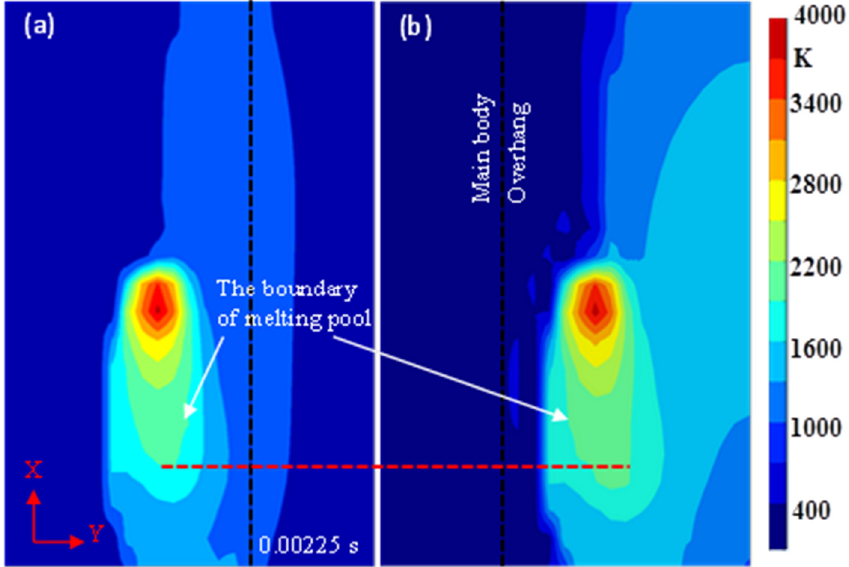
Figure 2. The temperature distribution on the X-Y plane (Z = 0, the top surface of the overhang) at 0.00225 s. ( a ) Forming from the main body; ( b ) Forming from the overhang. When the time was 0.00225 s, the laser was irradiating the midpoints of both track 3. The two tracks have the same distance from the body in both simulations. The main body and the overhang are distinguished by the black dash lines in Figure 2. The temperature range at a point can be confirmed by the isothermal curves and the thermal gradient can be estimated by the isothermal density. The melting temperature of Ti-64 alloy was set to 1873–1923 K. The white arrows in Figure 2 indicate the 1900 K isotherm curves, within which are the melting pools. The melting pools are elongated in shape along the pathway of the moving heat source, and the length in Figure 2a is less than in Figure 2b, which are discerned by the red dashed line. Figure 2 also shows that the scanned area has a higher temperature than the unscanned area and that the temperature close to the heat source is higher than that of the surrounding area. Moreover, a lower temperature and a higher thermal gradient can be found in Figure 2a compared to Figure 2b, which is further illustrated in Figure